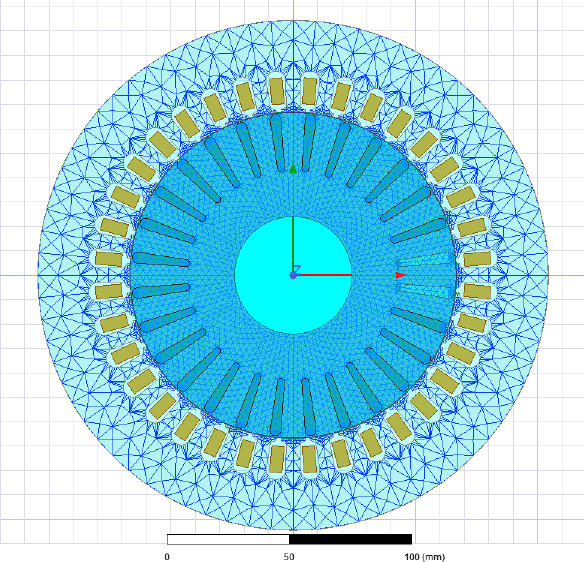
Figure A2. The 2D FE mesh of 11,000 elements used in simulations of the tested IM operation.